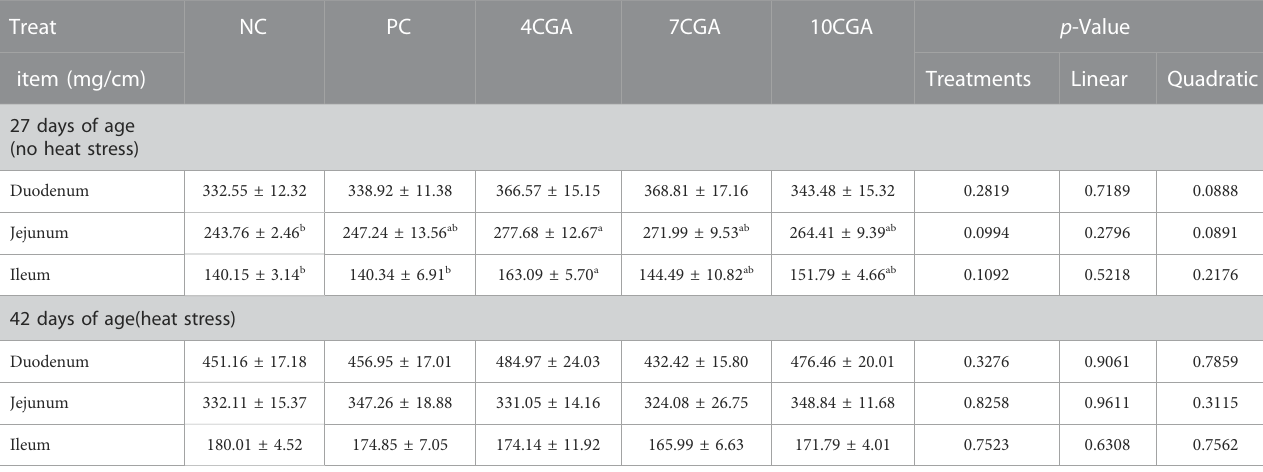
TABLE 4 Effects of in ovo feeding of chlorogenic acid on intestinal quality index of